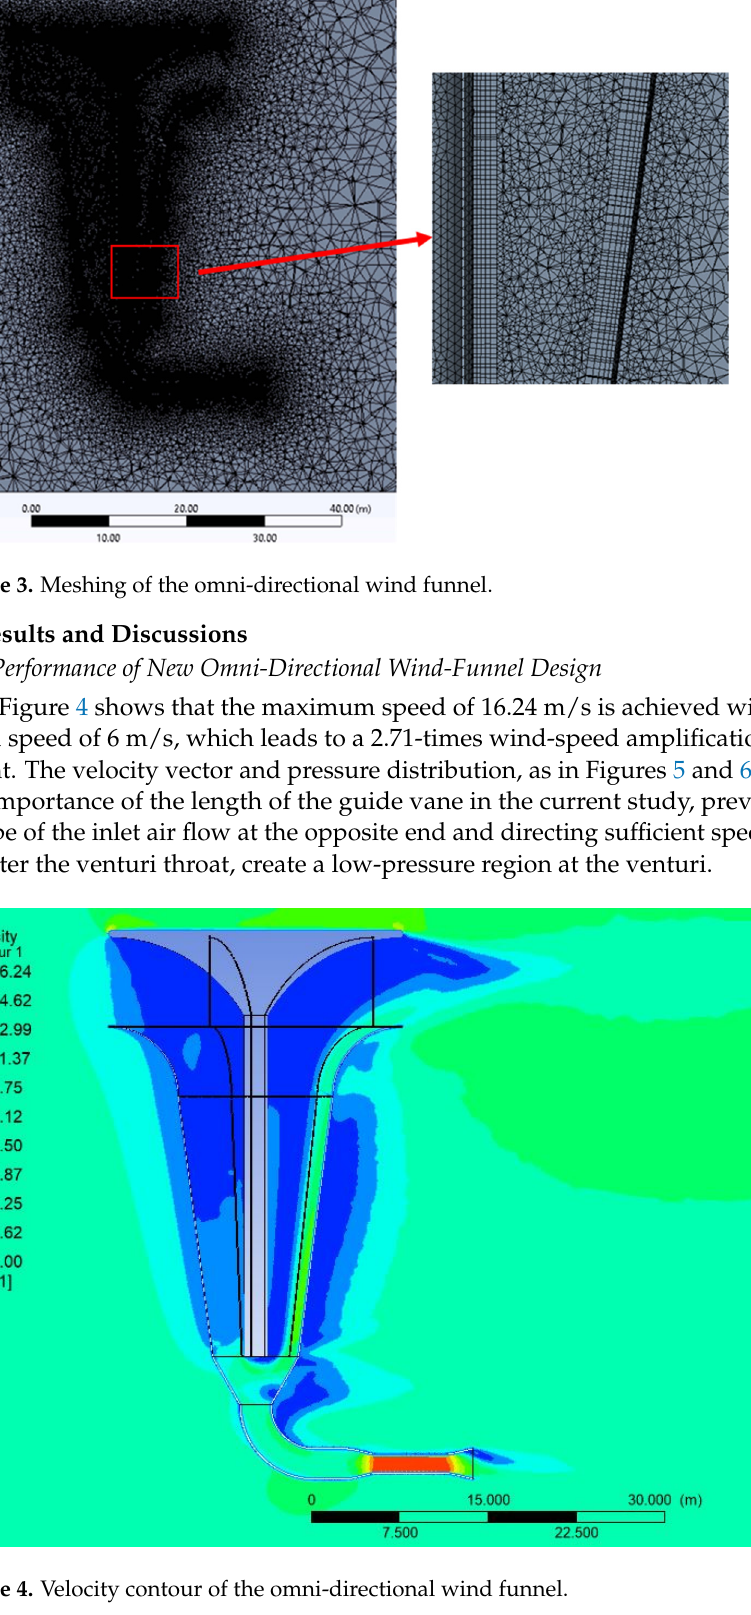
Figure 2. Dimensions of computational domain.